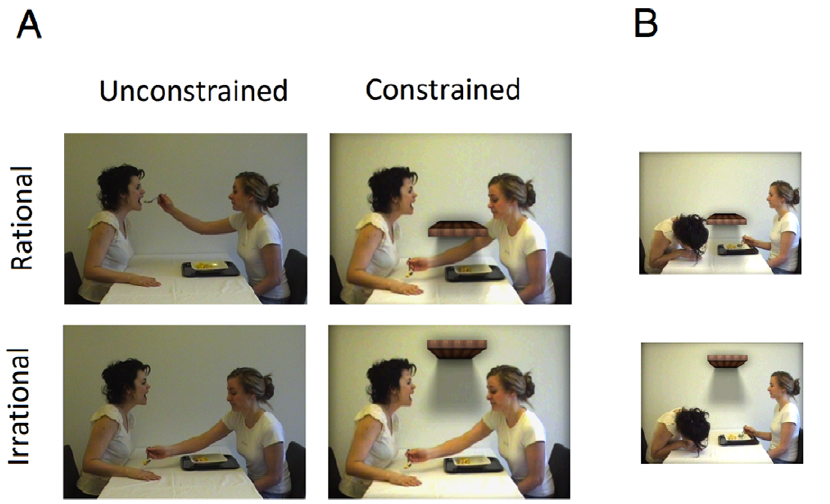
Figure 1. Snapshots of the feeding action; bringing food to the recipients hand/mouth. (A). Snapshots of the recipient leaning forward to eat off the back of her hand (B) in the irrational and constrained condition (upper) and the rational and constrained condition